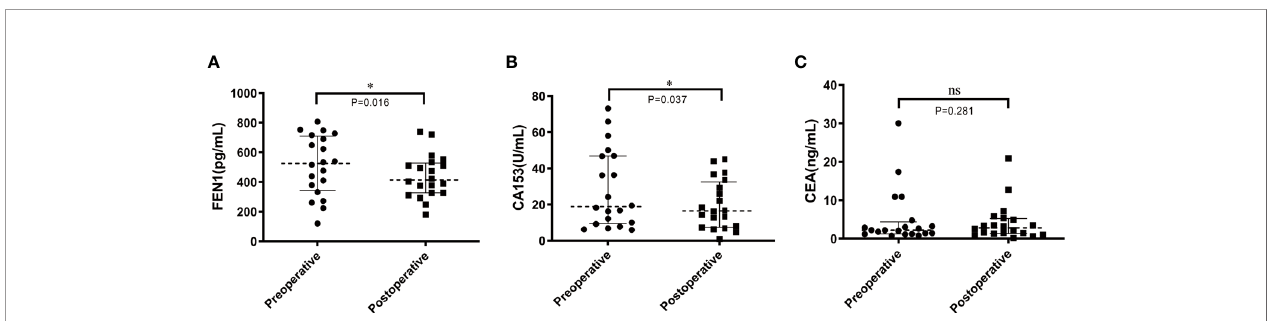
FIGURE 6 | Scatter diagram analysis of the serum levels of FEN1, CA153, and CEA in pre-and post-operative BC patients. (A) FEN1. (B) CA153. (C) CEA. n = 20. *P < 0.05; ns, not signi fi cant.